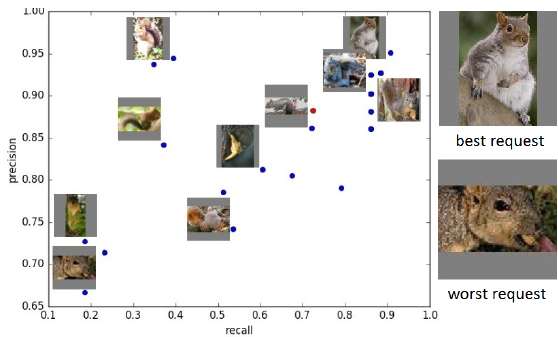
Figure 3. Precision and recall (for fixed threshold) for different requests for class squirrel